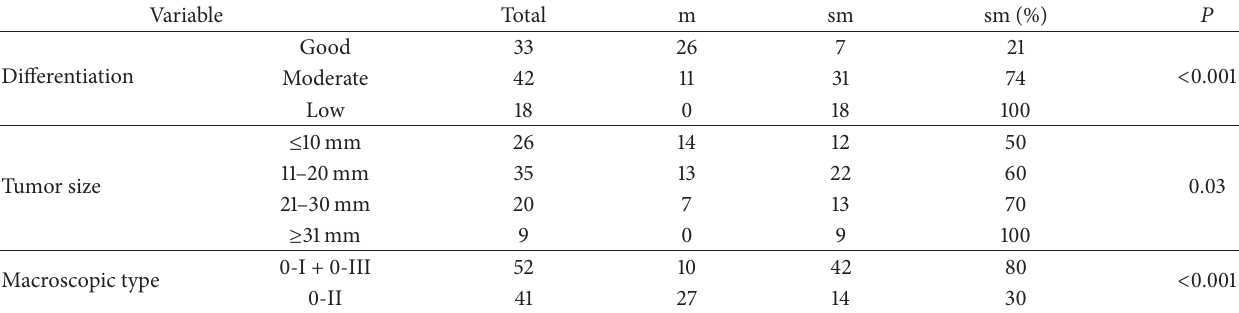
Table 3: Relationship between clinicopathologic factors and depth of